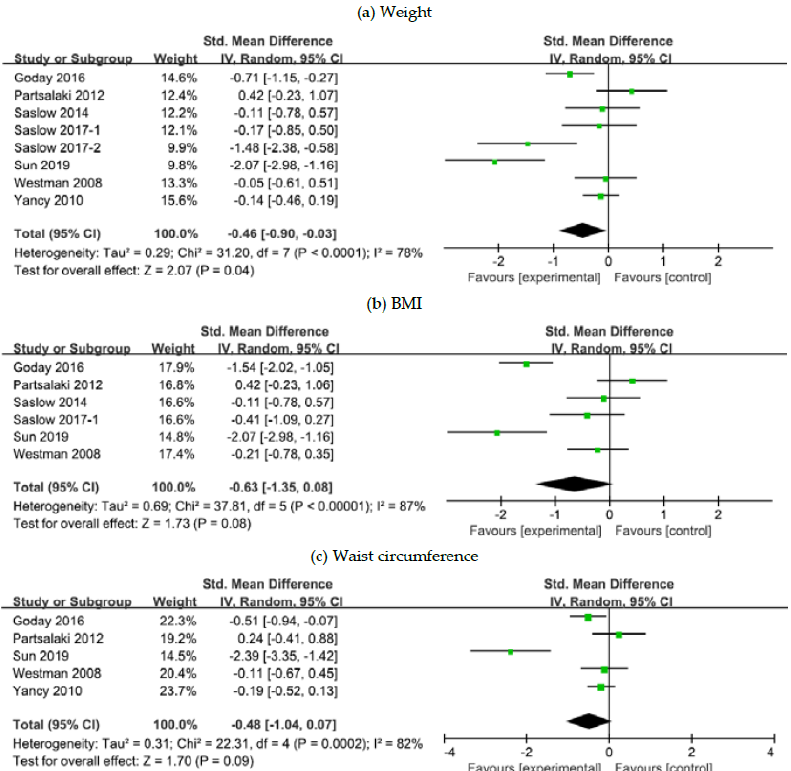
Figure 4. Forest plots for association between weight control and ketogenic diet in patients with overweight or obesity and with or without T2DM: ( a ) Changes in body weight; ( b ) changes in BMI; ( c ) changes in waist circumference. Abbreviations: CI, confidence interval; BMI, body mass index; T2DM, type 2 diabetes mellitus.